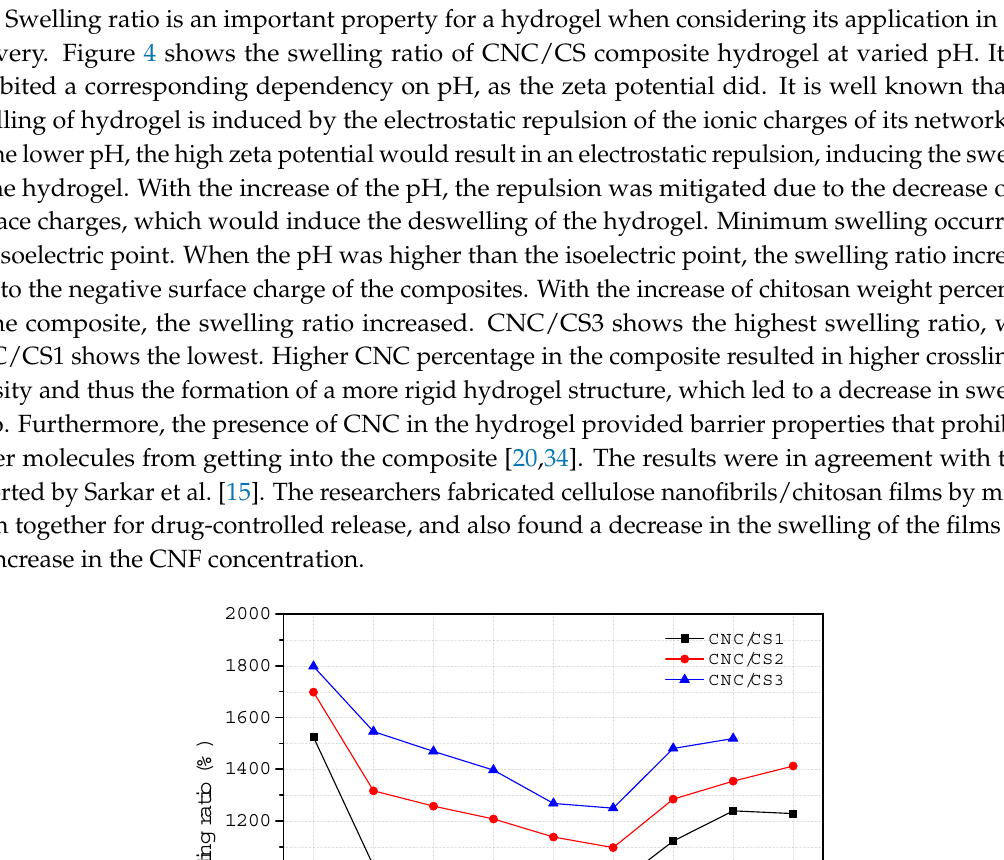
Figure 3. Zeta potential of CNC/CS composites.